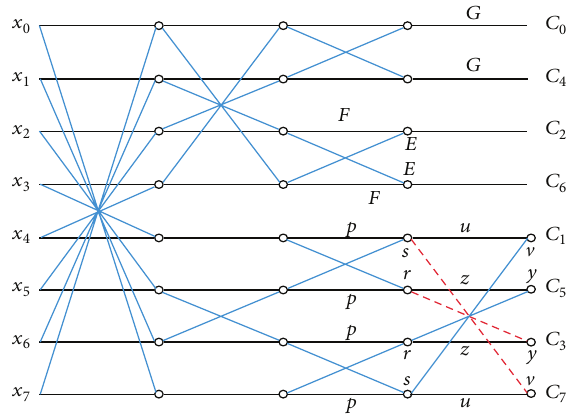
Figure 2: The signal flow graph of fast integer DCT using direct